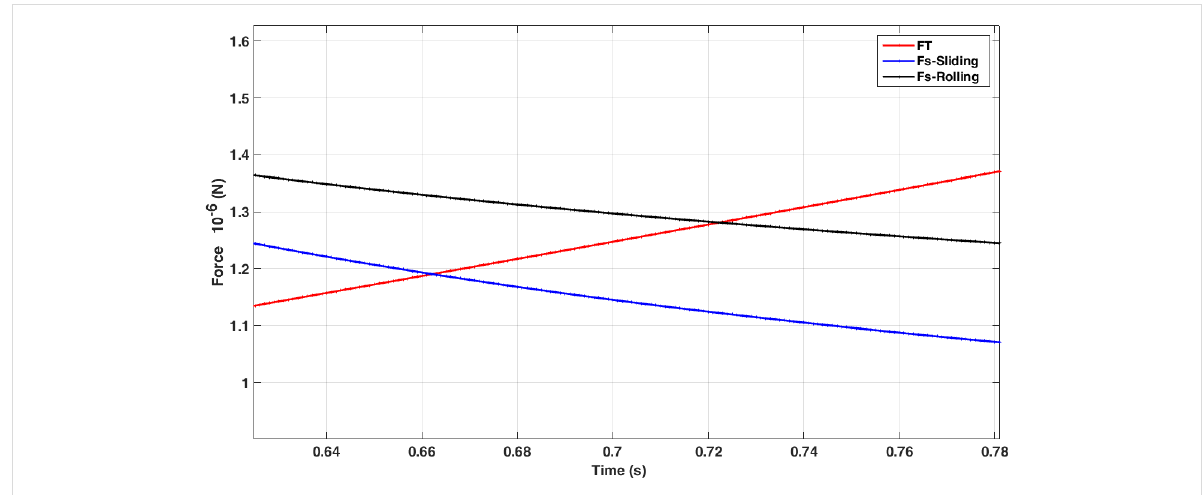
Figure 5: Simulation of critical times and forces in sliding and rolling modes for a gold nanoparticle with a length of 25 μ m and aspect ratio of 30.